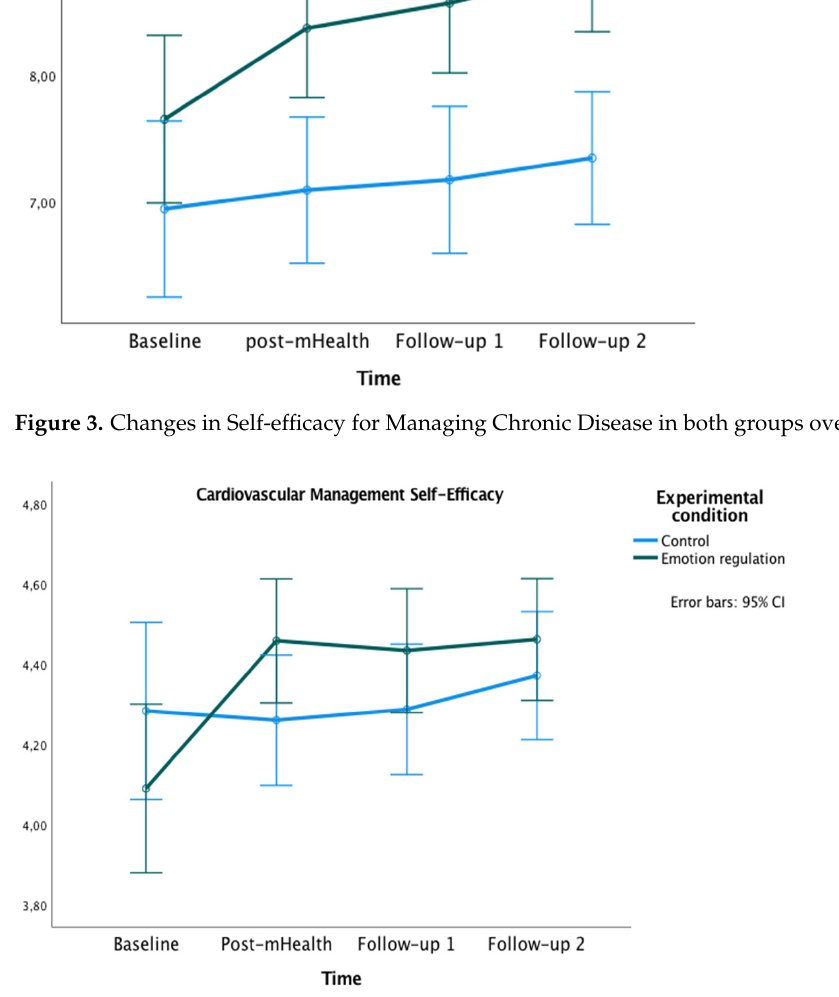
Figure 4. Changes in Cardiac Management Self-Efficacy in both groups over time.